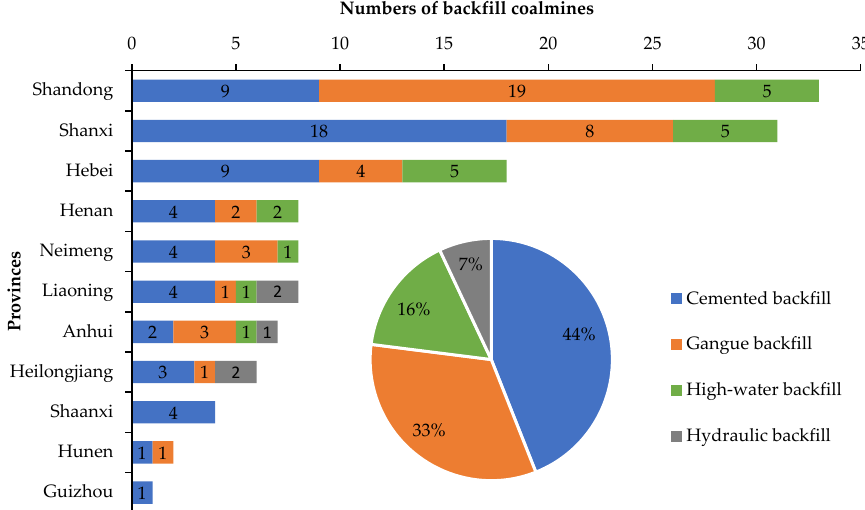
Figure 3. Distributions of backfill coal mines and backfill materials in China (all data are from the China National Knowledge Infrastructure).